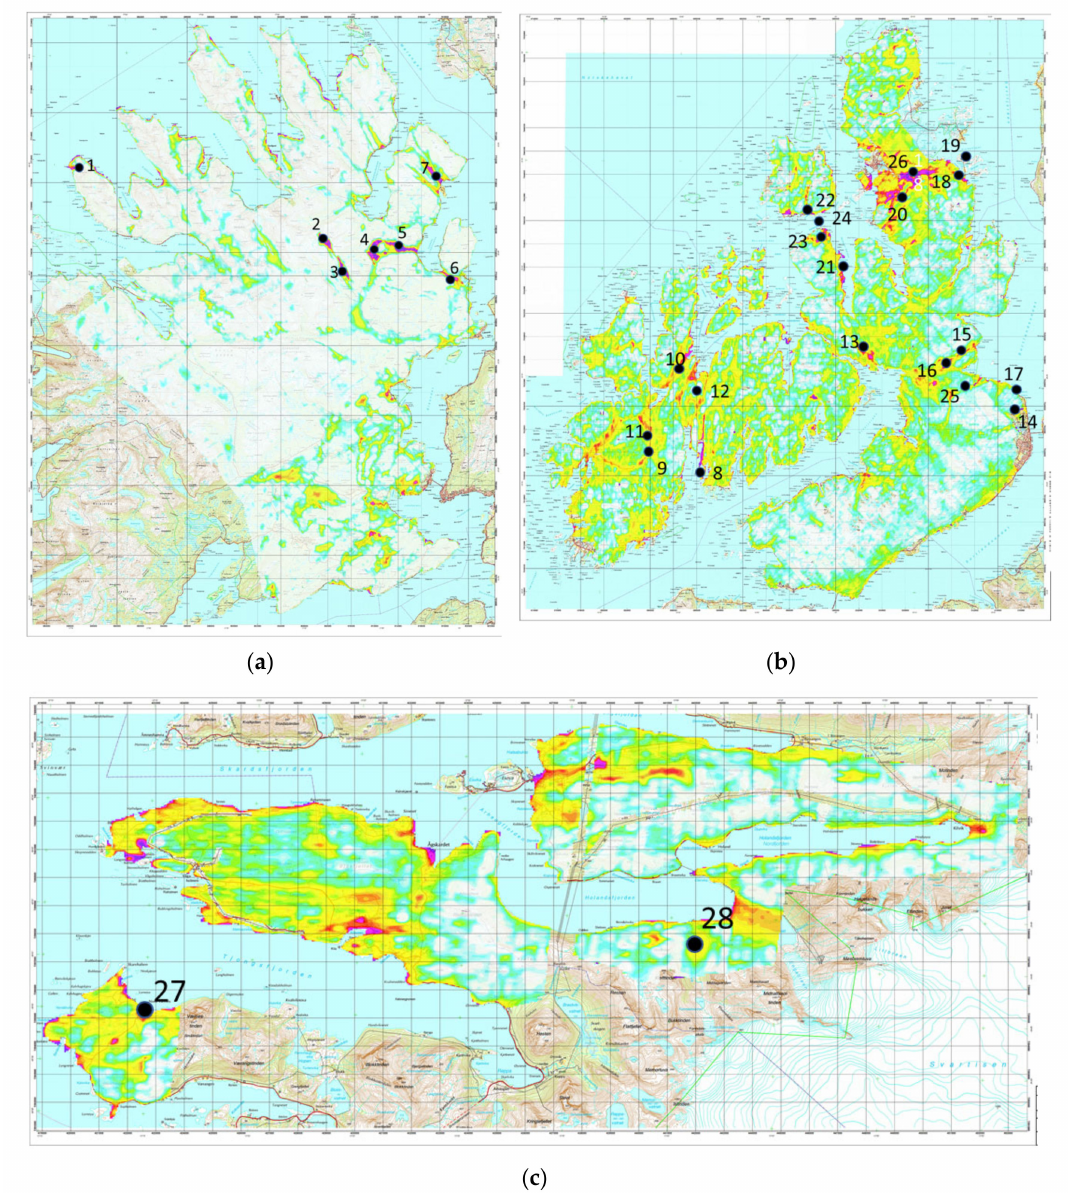
Figure 2. Maps of airborne EM (7000 Hz) with graphite occurrences: ( a ) Senja, ( b ) Vesterålen, and ( c ) Holandsfjorden. The names of occurrences are listed in Table 1, compiled from data reported in [51,59,60]. See links in the text for access to map files in high